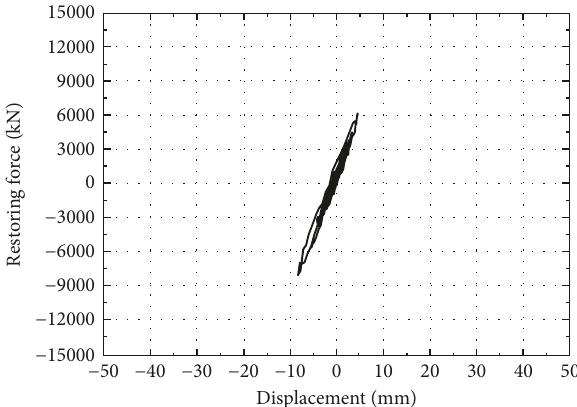
Figure 22: Hysteresis curve of intensity 7 frequently of synthesized (longitudinal input).